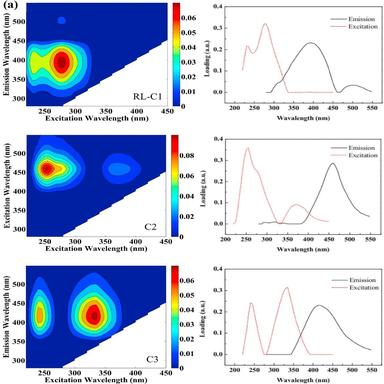
Identification of the three fluorescent components of DOM in raw (a) and bio-treated (b) leachate based on EEM-PARAFAC analysis, and the changes in normalized Fmax of the three fluorescent components of DOM in raw (c) and bio-treated (d) leachate during oxidation, respectively.